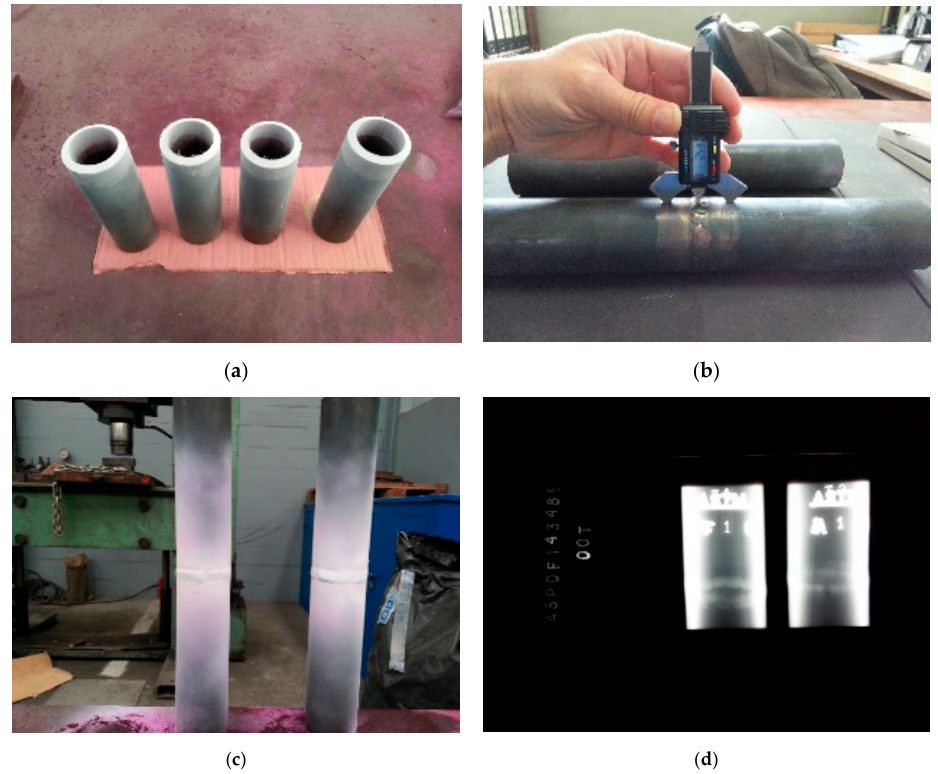
Figure 3. Different non-destructive test stages regarding the samples approval: ( a ) Liquid penetrant before welding; ( b ) Dimensional control; ( c ) Liquid penetrant after welding and cutting; ( d ) X-ray analysis.